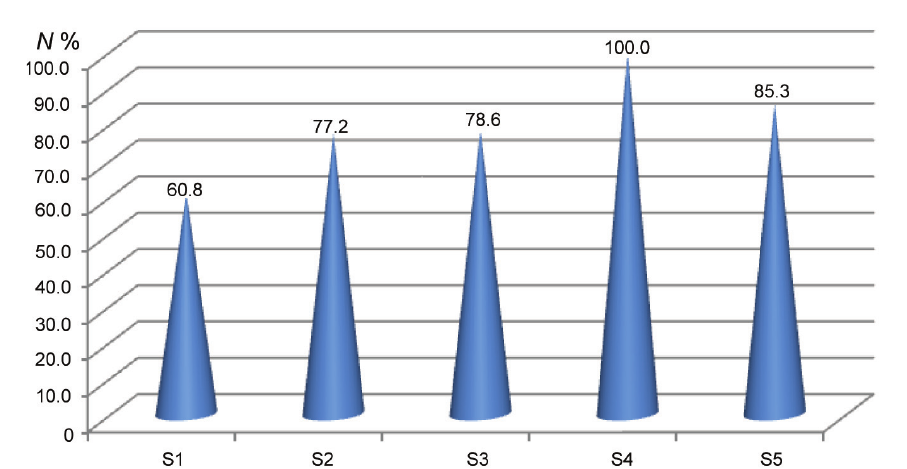
figure 7. Graphic representation of alternatives’ ranking according to CoPras